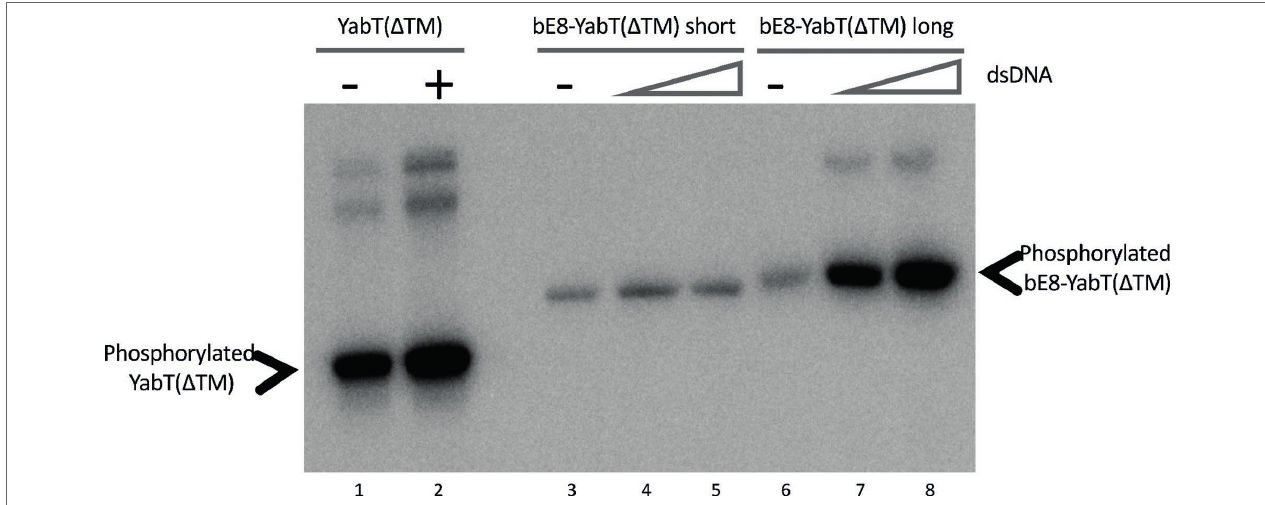
FIGURE 3 | Autophosphorylation activity of the short and long forms of the bE8-YabT( ∆ TM) fusion protein. About 1.6 μ M protein samples were incubated with 0 nM (lane 1, 3 and 6), 33 nM (lanes 2, 4, and 7), and 67 nM (lanes 5 and 8) dsDNA. Autophosphorylation reactions were started by adding 10 mM ATP containing 20 mCi mmol-1 [ γ - 32 P]-ATP. The samples were analyzed by SDS-PAGE, and the radioactive phosphorylated proteins were revealed by autoradiography. The activity of the short and long forms of the bE8-YabT( ∆ TM) fusion protein is compared to the activity of a YabT( ∆ TM) sample used as positive control. Phosphorylated YabT and bE8-YabT samples are indicated by arrows. Upper band(s) are observed when YabT is active. They could correspond either to minor multimeric states of the phosphorylated protein or to a minor E. coli contaminant recognized as substrate by the poorly specific